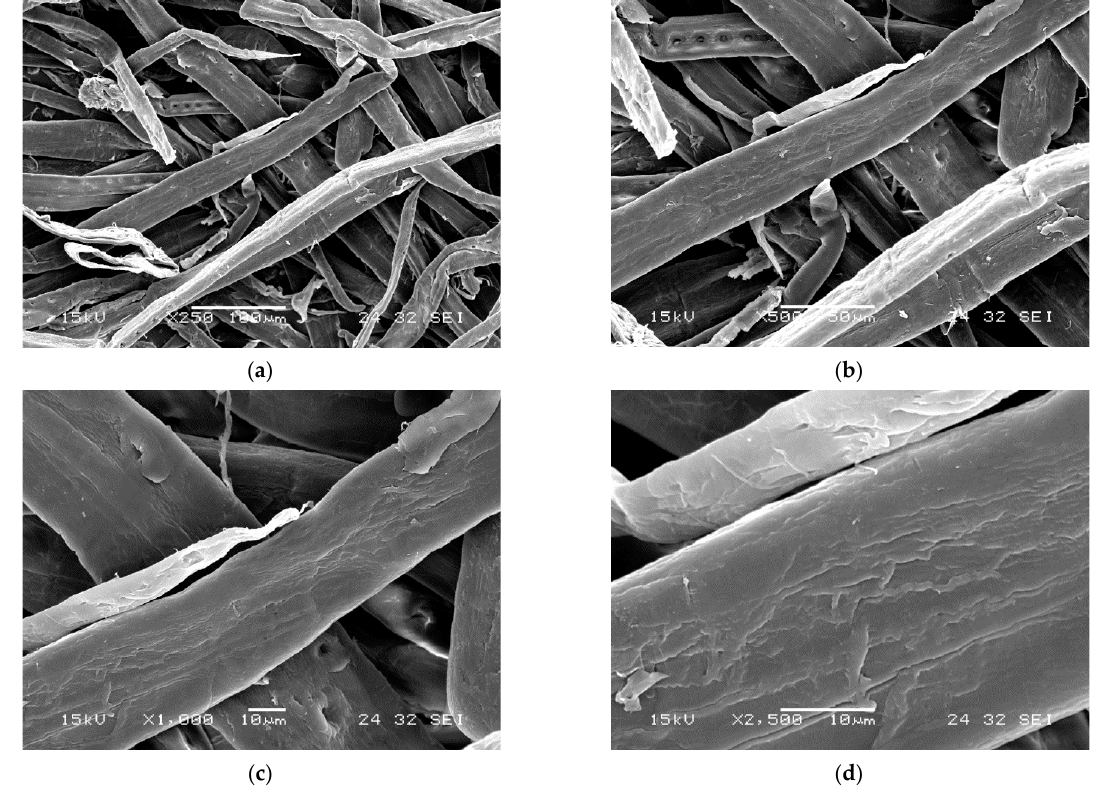
Figure 2. Scanning electron micrographs of gels derived from cellulose-based materials–kraft softwood fibers. ( a ) Magnification 250×. ( b ) Magnification 500×. ( c ) Magnification 1000×. ( d ) Magnification 2500×.